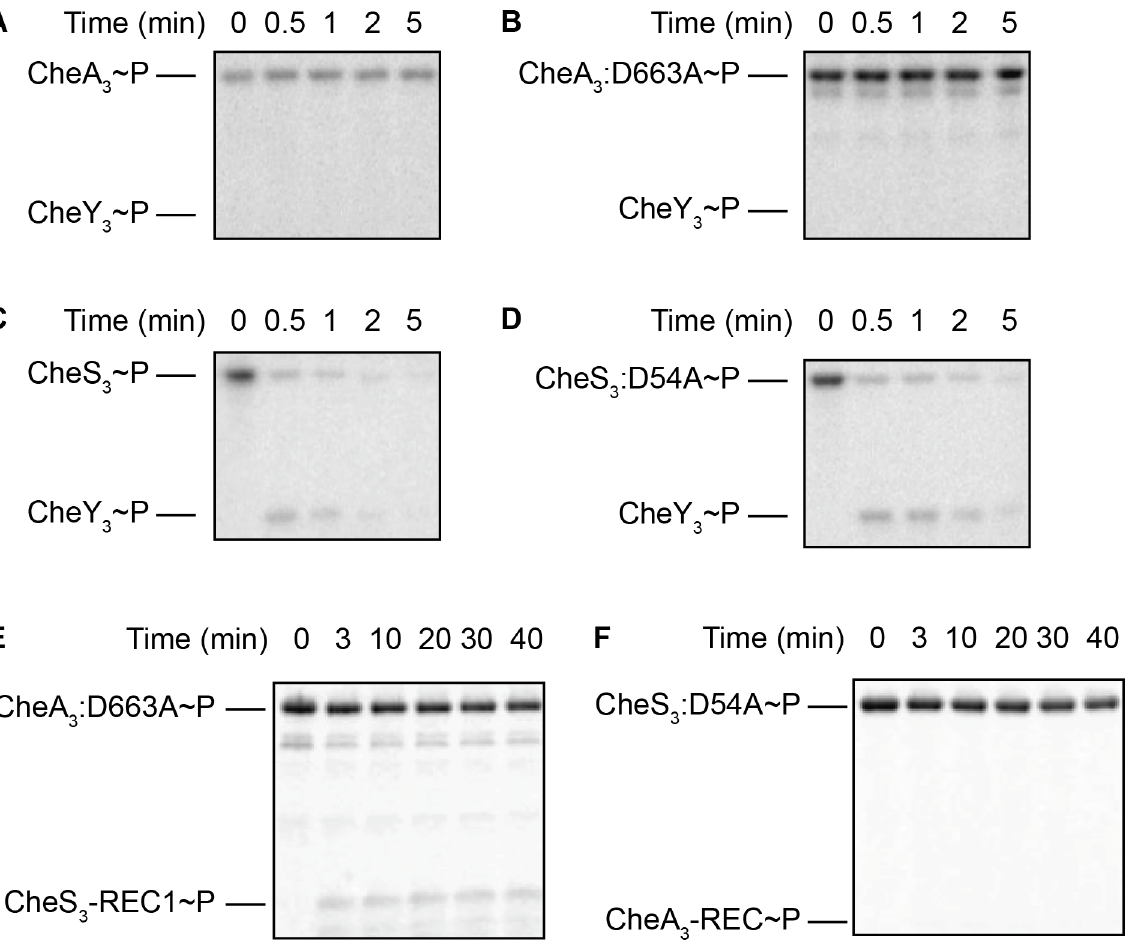
Figure 5. Intermolecular phosphoryl transfer events assayed among CheS 3 , CheA 3 , and CheY 3 . 2–5 m M CheS 3 , CheA 3 , or their REC mutant forms were autophosphorylated in 200 m M ATP for 30 min before 1/10 volumes of 65 mM CheY 3 or REC domain truncations were added. (A, B) Neither CheA 3 , P nor CheA 3 :D663A , P are able to phosphorylate CheY 3 in Buffer 9 containing K + and 6 mM Ca 2 + . (C, D) CheS 3 , P and